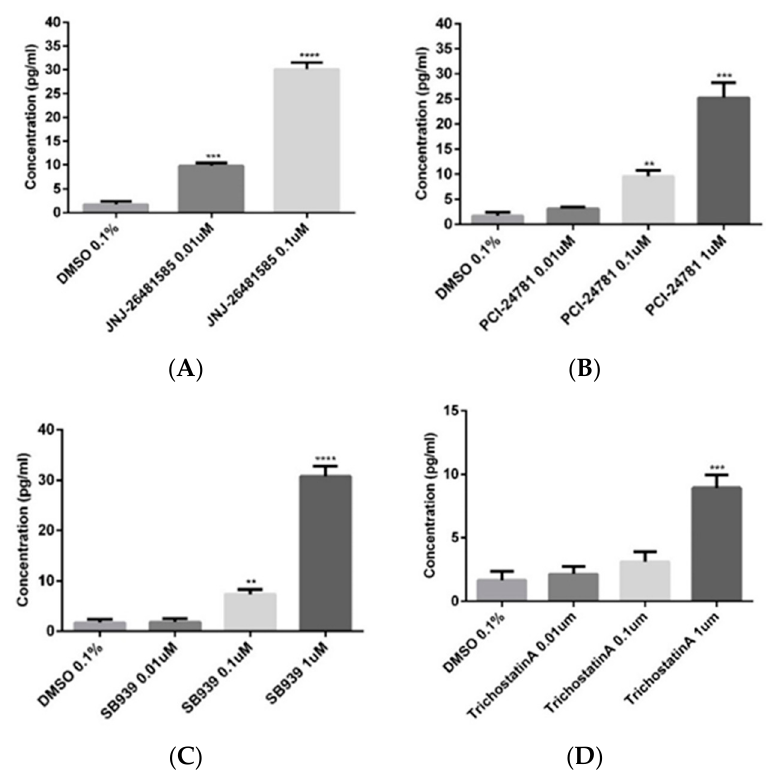
Figure 4. ELISA results showing that BDNF protein was significantly increased in HEK293 cells upon treatment with JNJ-26481585, PCI-24781, and SB939 compounds. Trichostatin A was used as a positive control. Three biological replicates were used per treatment; Error bars represent SEM; ** p < 0.01, *** p < 0.001, **** p < 0.0001.